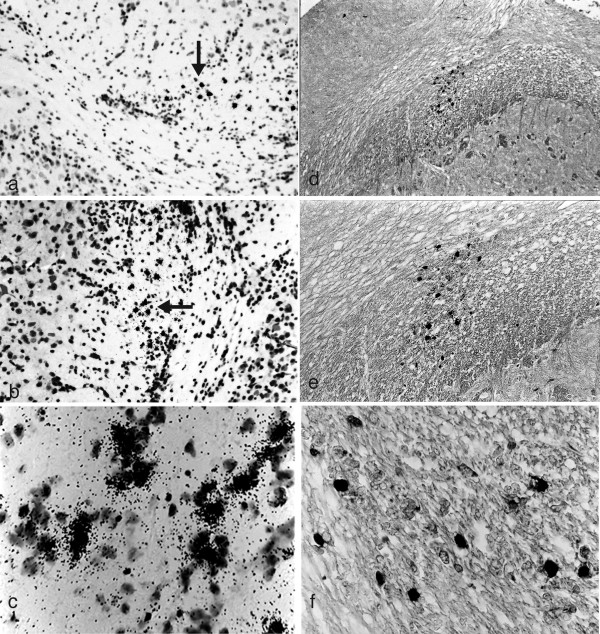
HSV-1 DNA and antigen positive cells are not present diffusely throughout the BST of BL/6 mice but are restricted to an area associated with the RTNBST. Ten-12 week ♀ BL/6 mice were infected with HSV-1 strain 2 via the oral mucosa. Three mice were examined every 3 days at necropsy from day 0 through 30 PI. Six micron thick serial sections of the brain were examined for 35S-labelled HSV DNA (ISH) and viral antigens (IHC) and counterstained with either H & E or CFV respectively. In representative sections, both viral DNA (Figure 1 a - c) and viral antigen (Figure 1 d - f) are identified on day 3 PI and restricted to a small area of the BST associated with the roots of the trigeminal nerve (RTNBST). (a) Small area of 35S-labelled HSV DNA positive cells (arrow) in the BST on day 3 PI (x100) (b) Higher power photomicrograph of HSV-1 DNA positive cells (arrow) on day 3 PI (x200) (c) High power photomicrograph of HSV-1 DNA positive cells on day 3 PI (x400) (d) Small area of HSV-1 antigen positive cells in the BST on day 3 PI (x100) (e) Higher power photomicrograph of HSV-1 antigen positive cells on day 3 PI (x200) (f) High power photomicrograph of HSV-1 antigen positive cells on day 3 PI (x400).